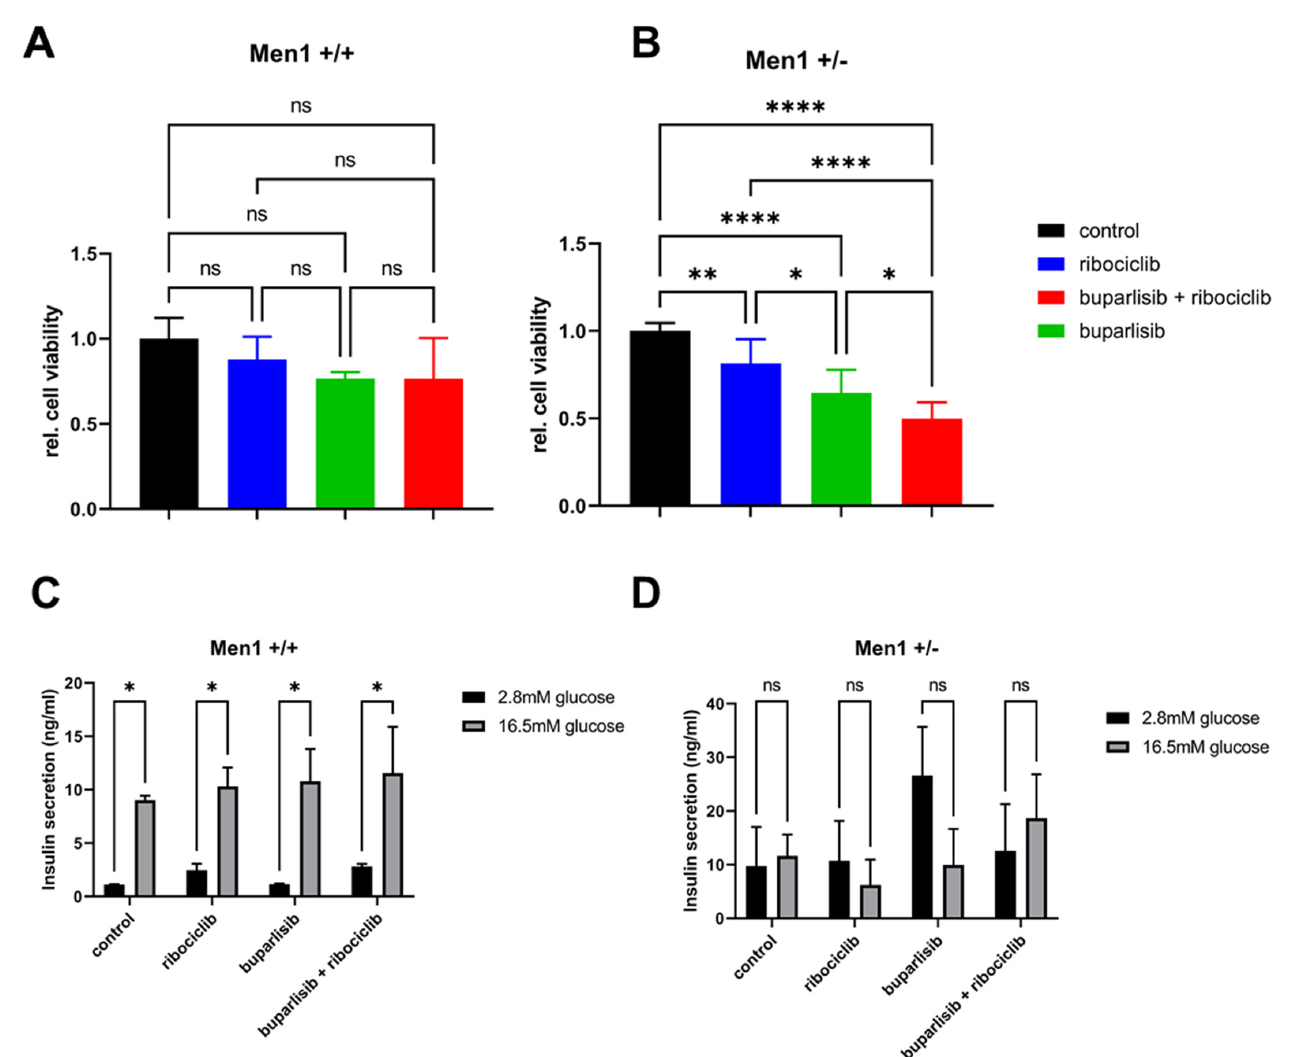
Figure 7. Effect of buparlisib and ribociclib on growth and glucose ‐ stimulated insulin secretion of primary 3D islet microtissues from Men1 knockout and control mice. ( A , B ) Primary islets were iso ‐ lated from age ‐ matched (18 months) heterozygous Men1 T/+ ( A ) and Men1 +/+ control ( B ) mice. Single cells were obtained from the islets and 3D microtissues generated using a hanging ‐ drop